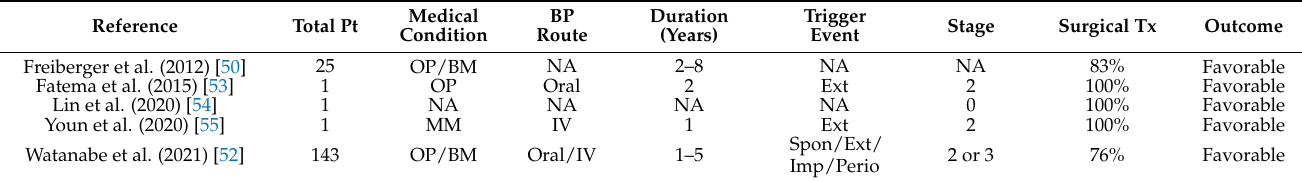
Table 3. Human studies of hyperbaric oxygen (HBO) administration for MRONJ treatment in the past 10